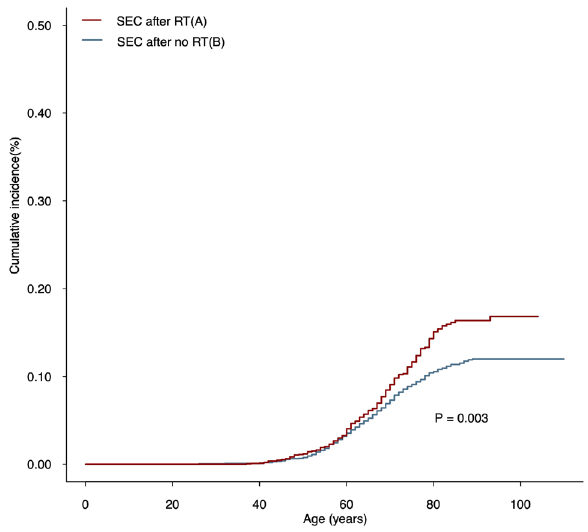
Figure 1. Comparisons of cumulative incidence of secondary esophageal cancer (SEC) between patients who received radiation therapy (RT) and patients who did not receive RT. P values were calculated with the Fine- Gray test. RT radiation therapy; SEC secondary esophageal